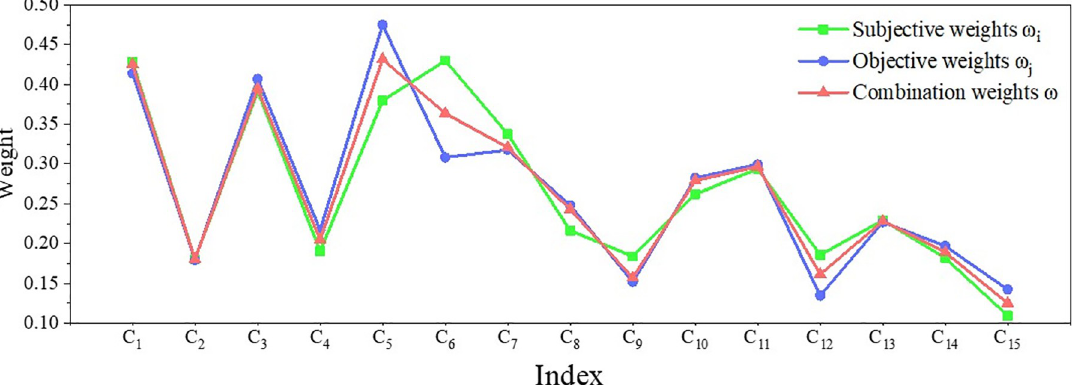
Fig 3. Index weight reference comparison chart. The data in Table 3 are presented in the form of line graphs. There are three curves in the graph, where green represents the subjective weights, blue represents the objective weights, and red represents the combination